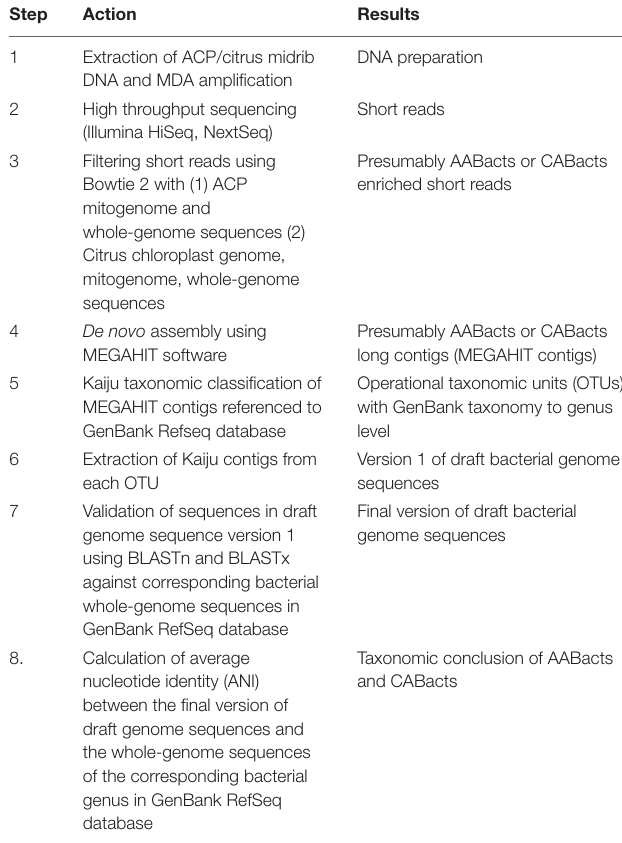
TABLE 2 | A pipeline to acquire draft genome sequences of ACP-associated bacteria (AABacts; represented by sample A-SBCA19) and citrus-associated bacteria (CABacts; represented by sample